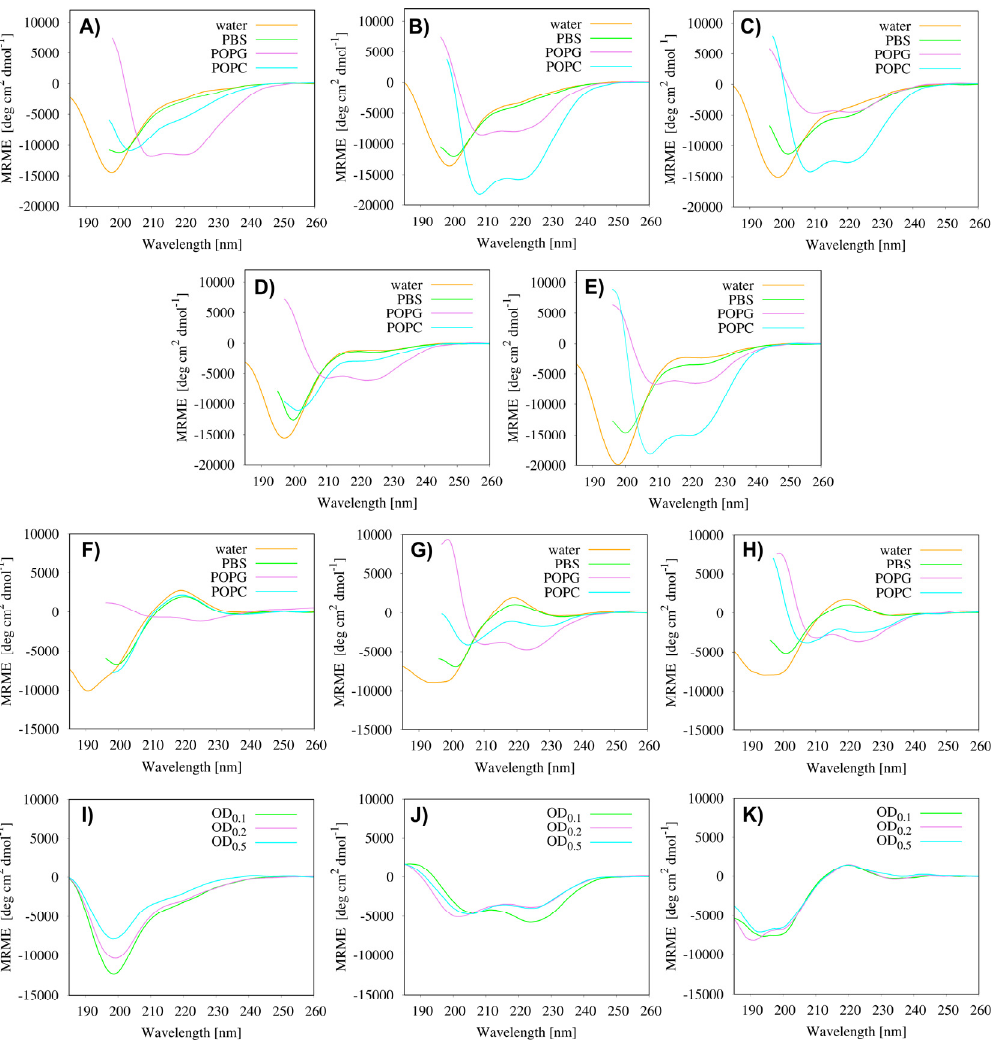
Figure 2. Far-UV CD spectra of ( A ) LL-I, ( B ) C 8 -LL-I, ( C ) C 10 -LL-I, ( D ) LK6, ( E ) C 8 -LK6, ( F ) ATRA-1, ( G ) C 8 -ATRA-1 and ( H ) C 10 -ATRA-1 recorded in water, PBS, POPC and POPG. Far-UV CD spectra of ( I ) C 8 -LL-I, ( J ) C 8 -LK6, ( K ) C 10 -ATRA-1 recorded in the presence of S. aureus . MRME denotes mean residue molar ellipticity. Table 3. α -Helix percentage determined from the CD spectra.